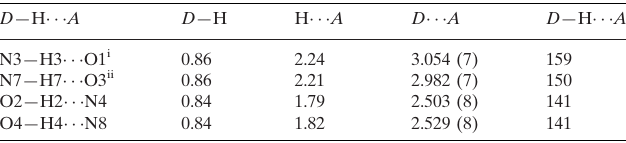
Hydrogen-bond geometry (A˚ , (cid:2)